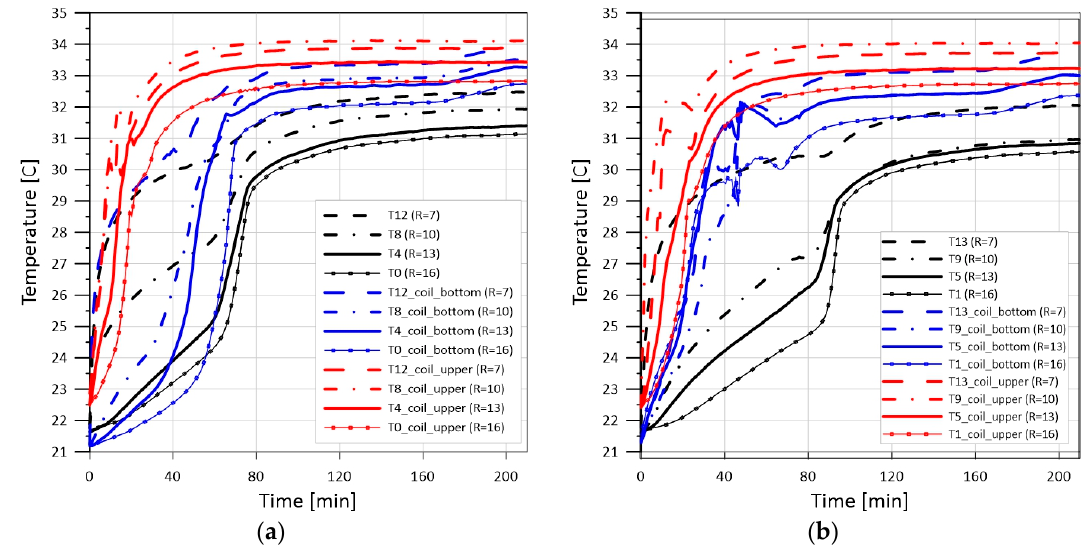
Figure 14. Temperature vs. time for increasing the radial position during the melting process with constant wall temperature condition ( Ts = 34 °C) on surfaces: S1 ( a ) and S2 ( b ).